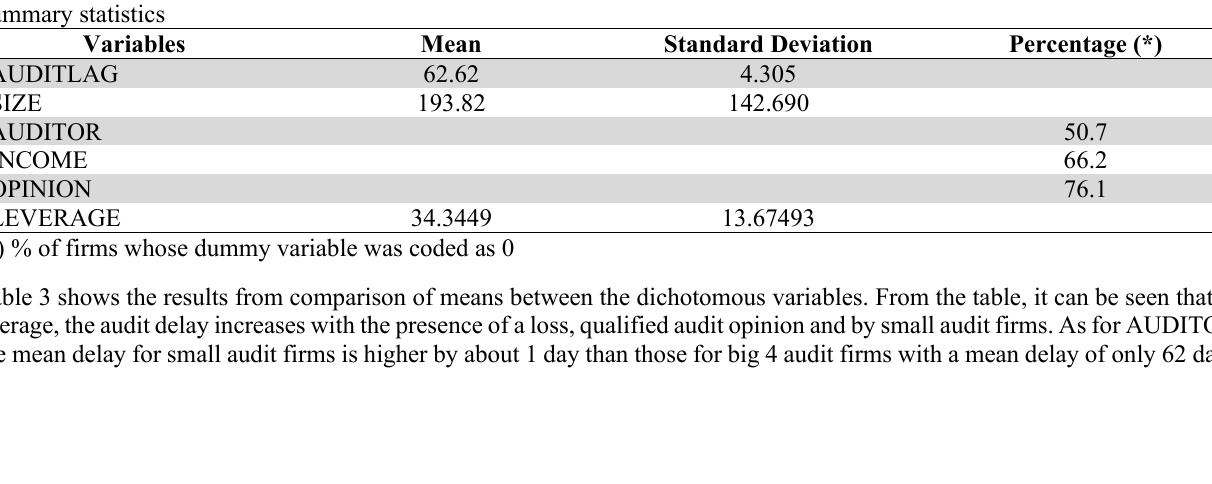
Definitions of independent variables Independent Variables